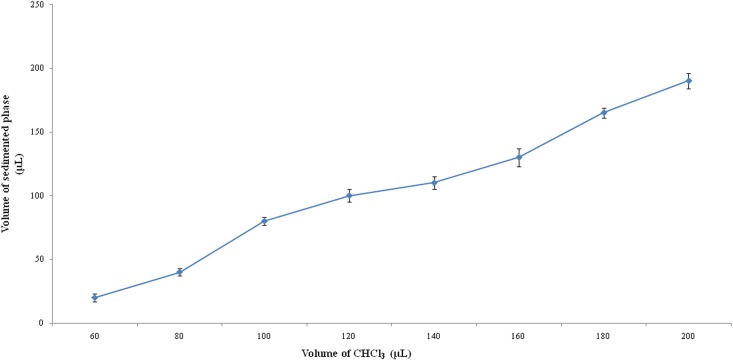
Effect of the volume of the extraction solvent (CHCl3) on the volume of the sedimented phase.